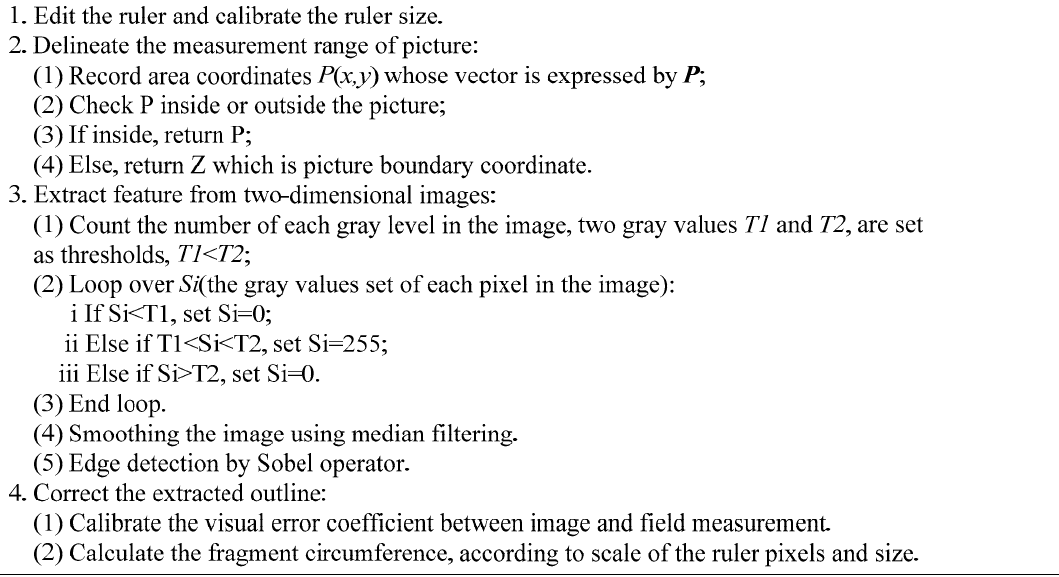
Figure 2. The algorithm of fragment size statistics.